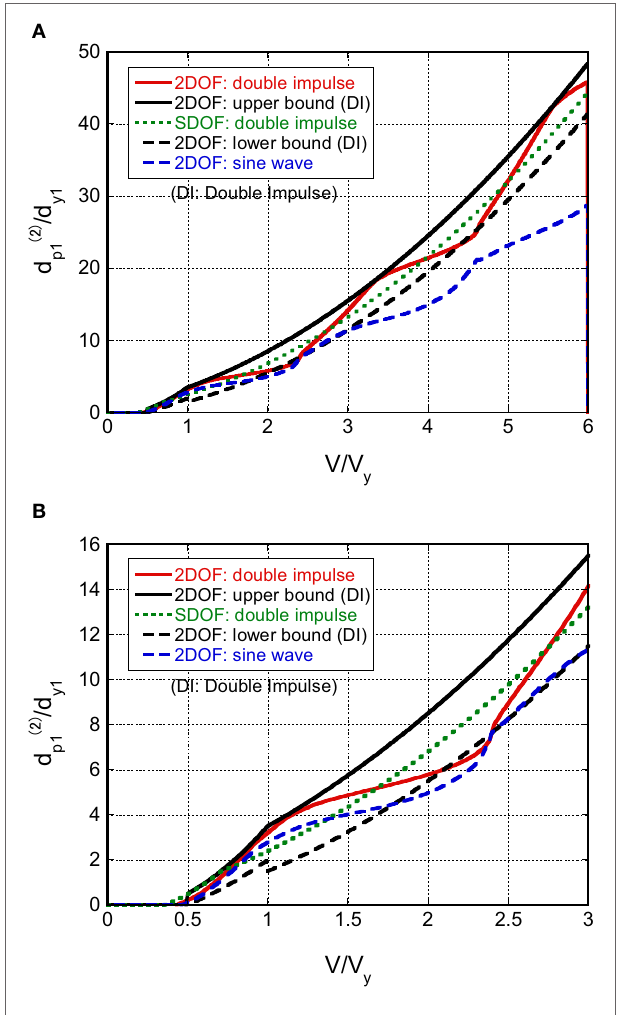
FigUre 12 | critical plastic deformation after the second impulse in the first story and their upper and lower bounds together with the upper bound of sDOF system and the response under the corresponding one-cycle sinusoidal wave. (a) Comparison up to V / V y = 6. (B)